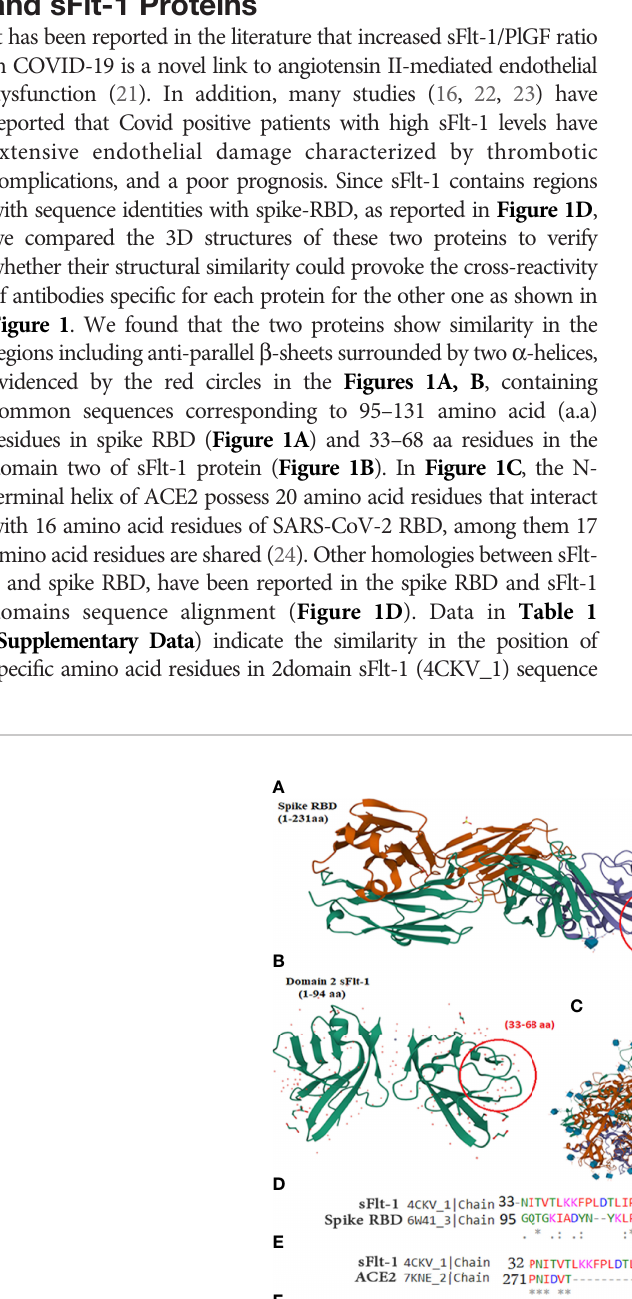
FIGURE 1 | 3D structure similarities between sFlt-1 and SARS-CoV-2 spike-RBD: (A) SARS-CoV-2 spike RBD structure (PDB, 6W41). The RBD domain is highlighted in purple color and amino acid residues 95 – 131 is highlighted in red circle. (B) 3D structure of domain-2 sFlt-1 (4CKV), red circle highlights the amino acid residues 33-68 with similar properties of the spike-RBD amino acid residues (95-131). (C) 3D structure of SARS-CoV-2 spike RBD (purple colour) bound with ACE2 (7KNE), pink colour (D) Sequence alignment of 33-68 amino acid residues of sFlt-1 with 95-131 amino acid residues of spike RBD. (E) Sequence alignment of 32-68 amino acid residues of sFlt-1 with 271-297 amino acid residues of ACE2 (7KNE). (F) Sequence alignment of 33-68 amino acid residues of sFlt-1 with 128-157 amino acid residues of neuropilin-1 (7JJC_1). All structures were retrieved from PDB